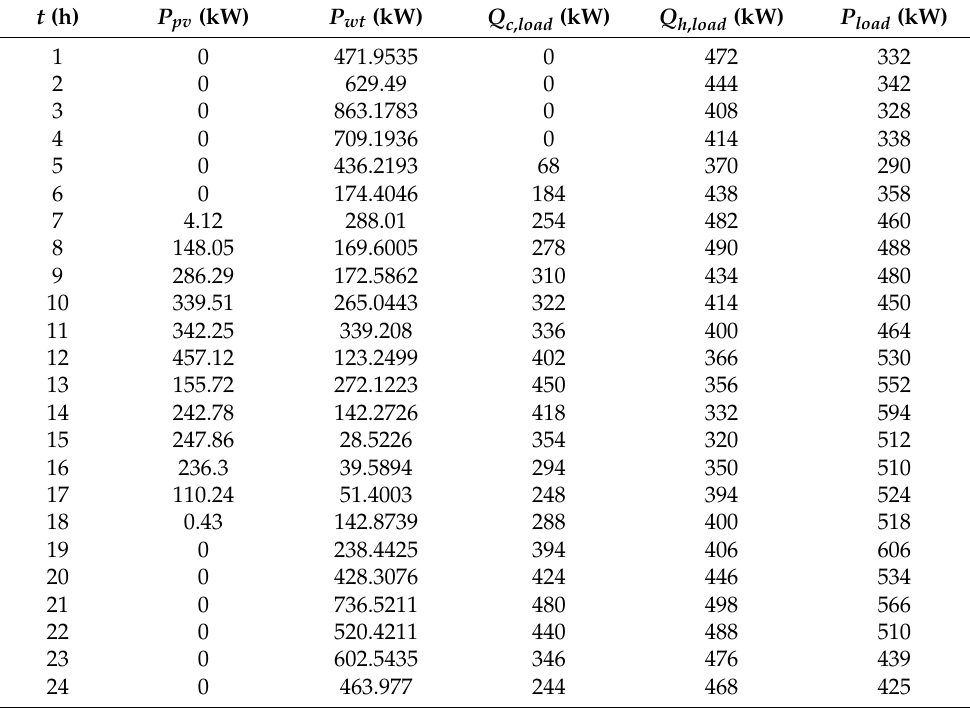
Table 8. Forecast values of wind turbine, photovoltaic, and load outputs on a typical day in